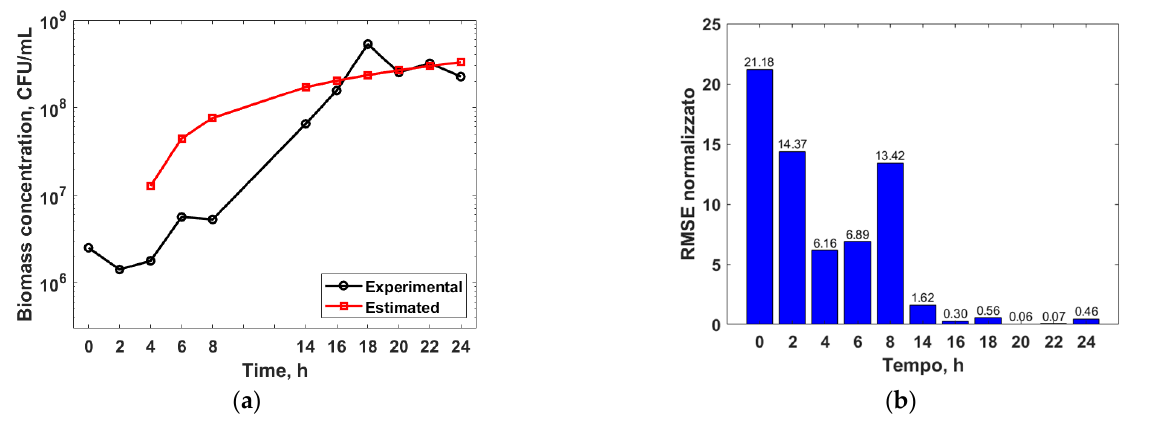
Figure 10. Genetic algorithm optimization by considering a single regression term and the response variable as a function of time and pH under pH control: ( a ) comparative trends and ( b ) normalized RMSE.